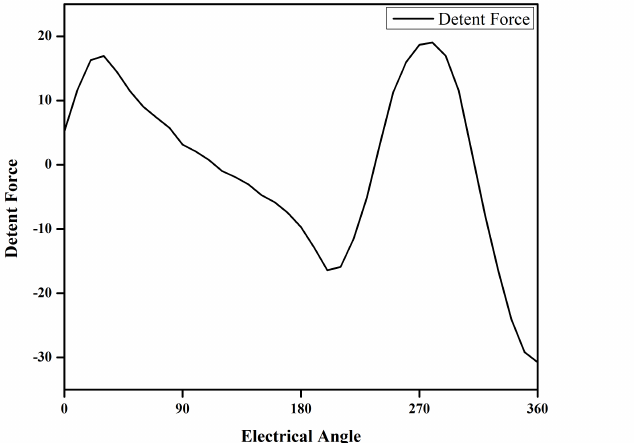
Figure 13. Detent